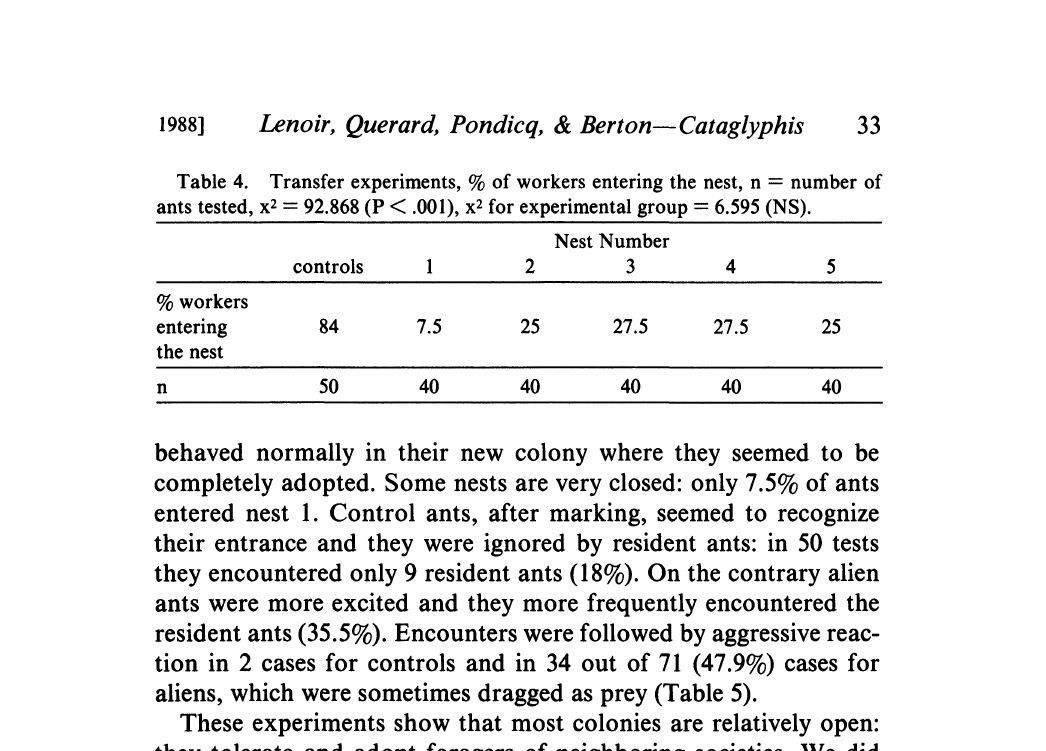
Table 4. Transfer experiments, % of workers entering the nest, n number of ants tested, x 92.868 (P < .001), x for experimental group 6.595 (NS).